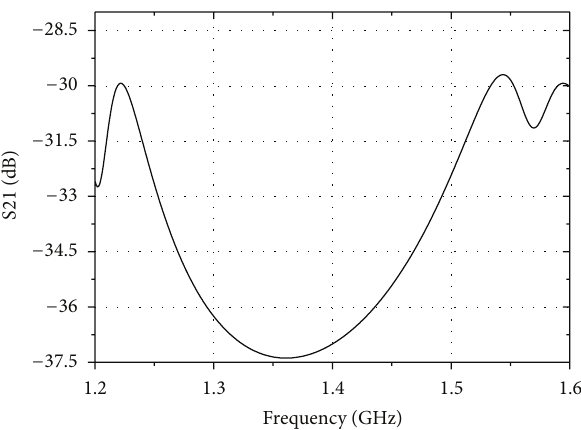
− 29.6 dB at the two bands, respectively. It shows that good isolation between the two antennas is